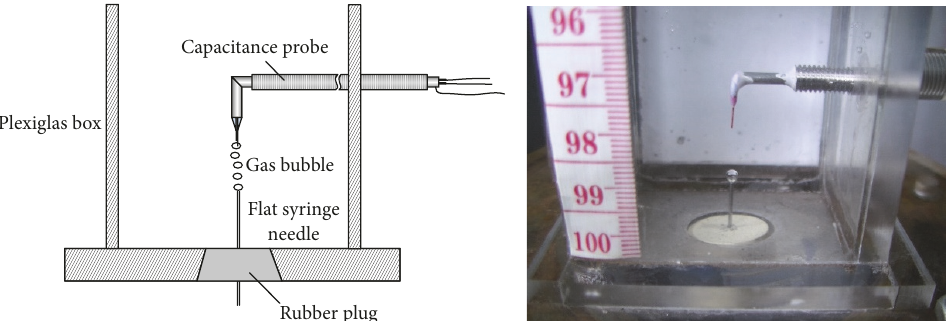
Figure 4: Probe verification facility.